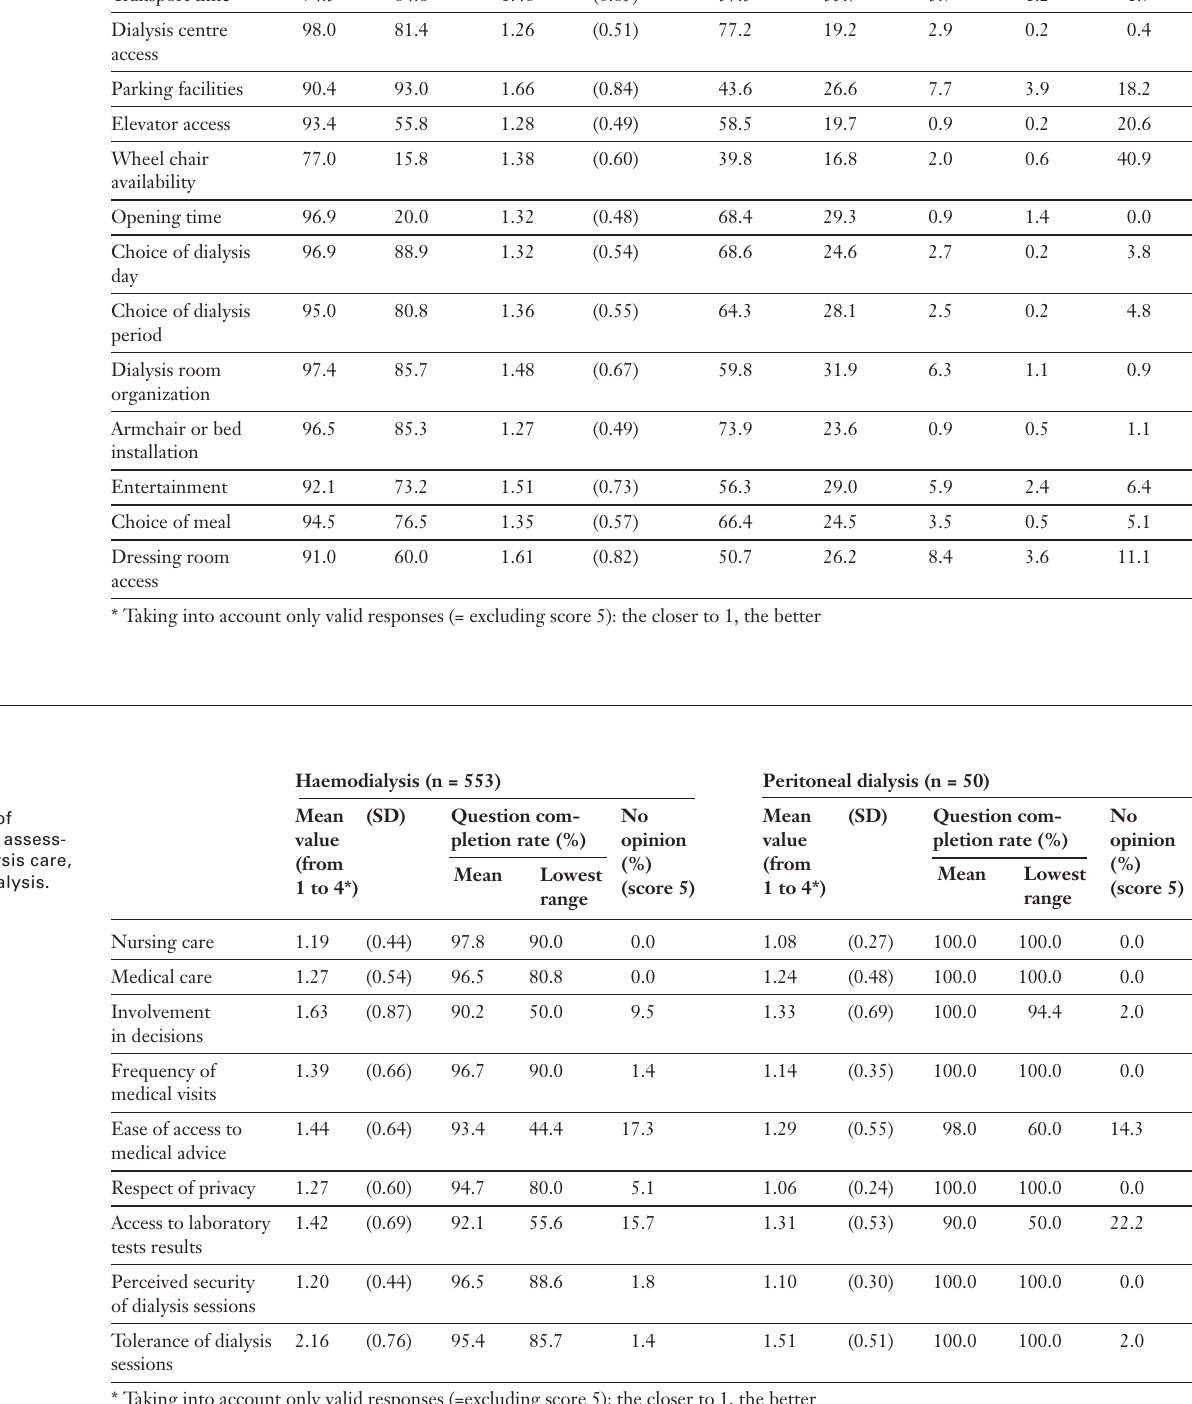
Table 1 Distribution of responses to access to haemodialysis centres and dialysis sessions (n = 553).